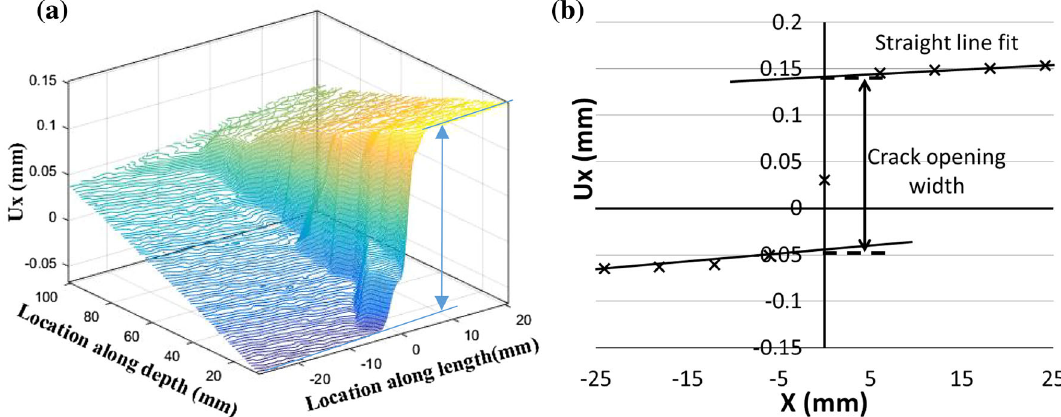
Fig. 7 a A 3-D representation of the displacement discontinuity introduced by the crack emanating from the notch; b Asymptote matching procedure for determining the crack opening